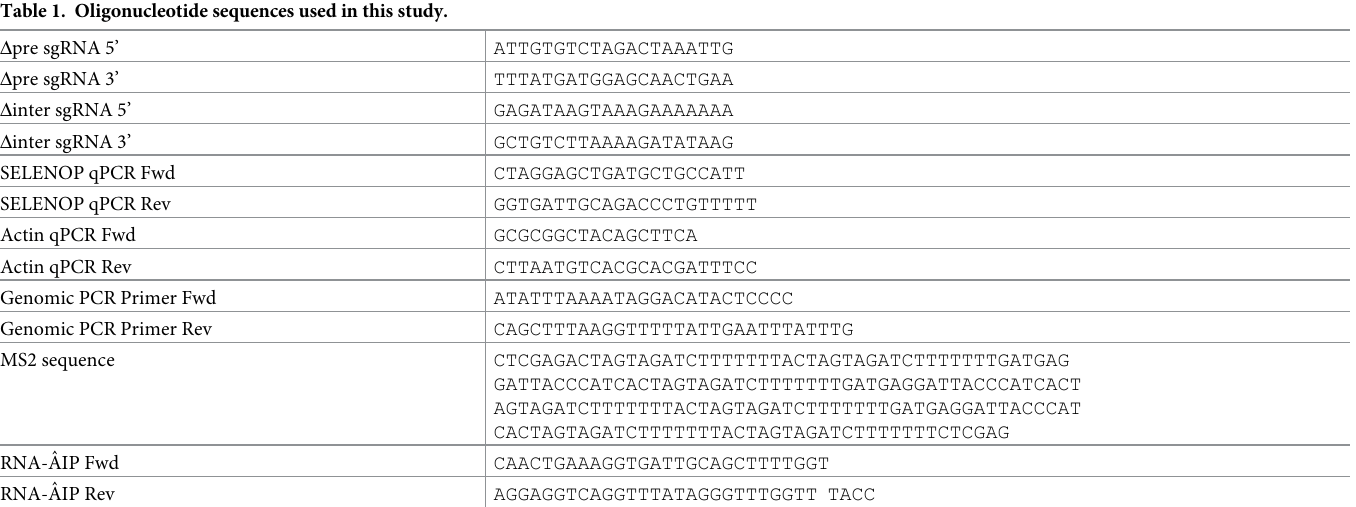
Table 1. Oligonucleotide sequences used in this